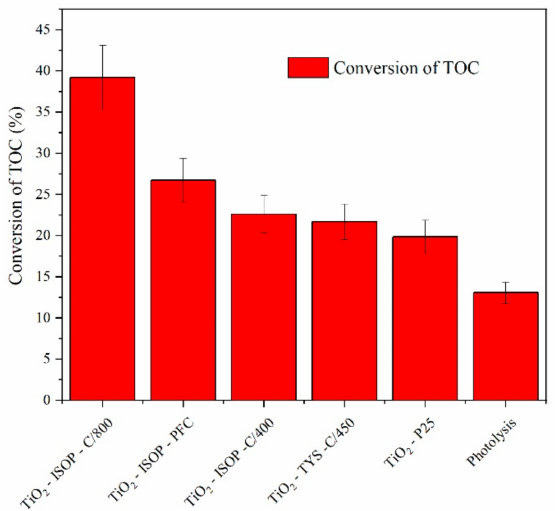
Figure 7. Conversion of total organic carbon (TOC) in presence of each photocatalyst and photolysis after 60 min of irradiation (254